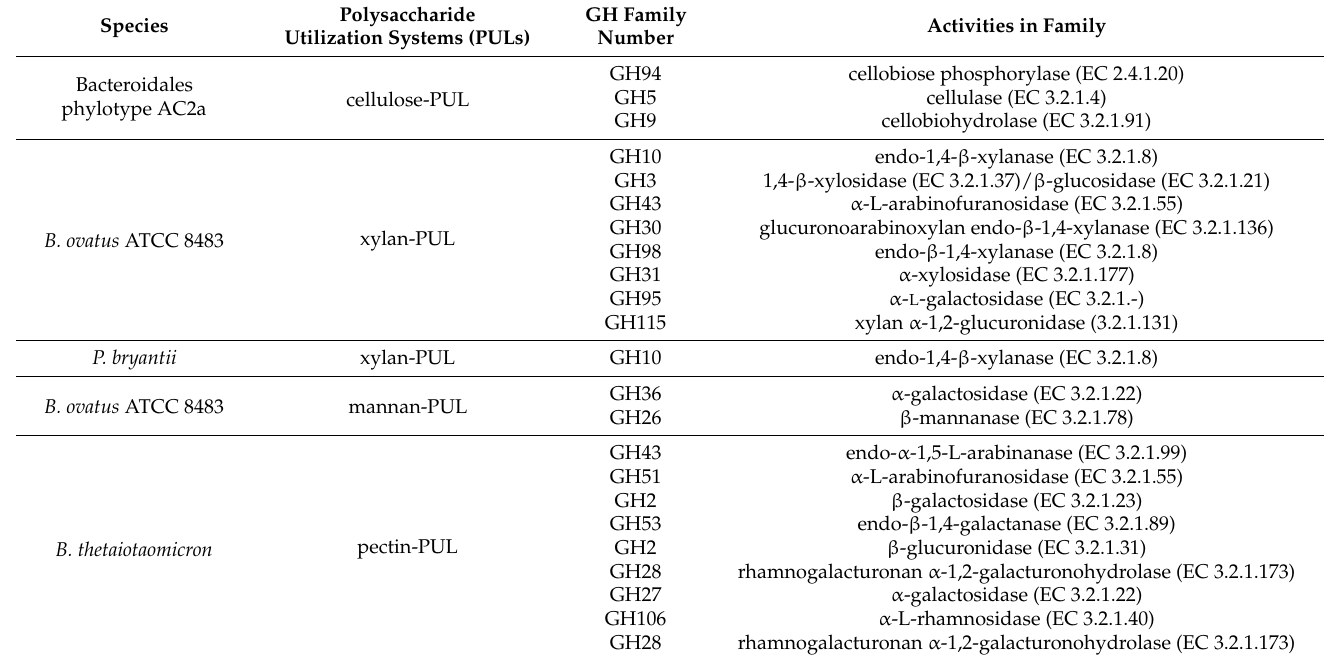
Table 1. List of selected Bacteroidetes PUL systems and their encoded GH